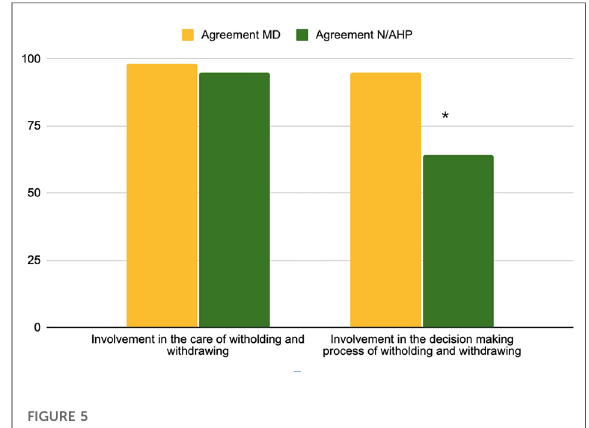
FIGURE 5 Questions 17 – 18 involvement in care and decision-making process % of the agreement for MD=physicians, N/AHP=nurses and allied health professionals.